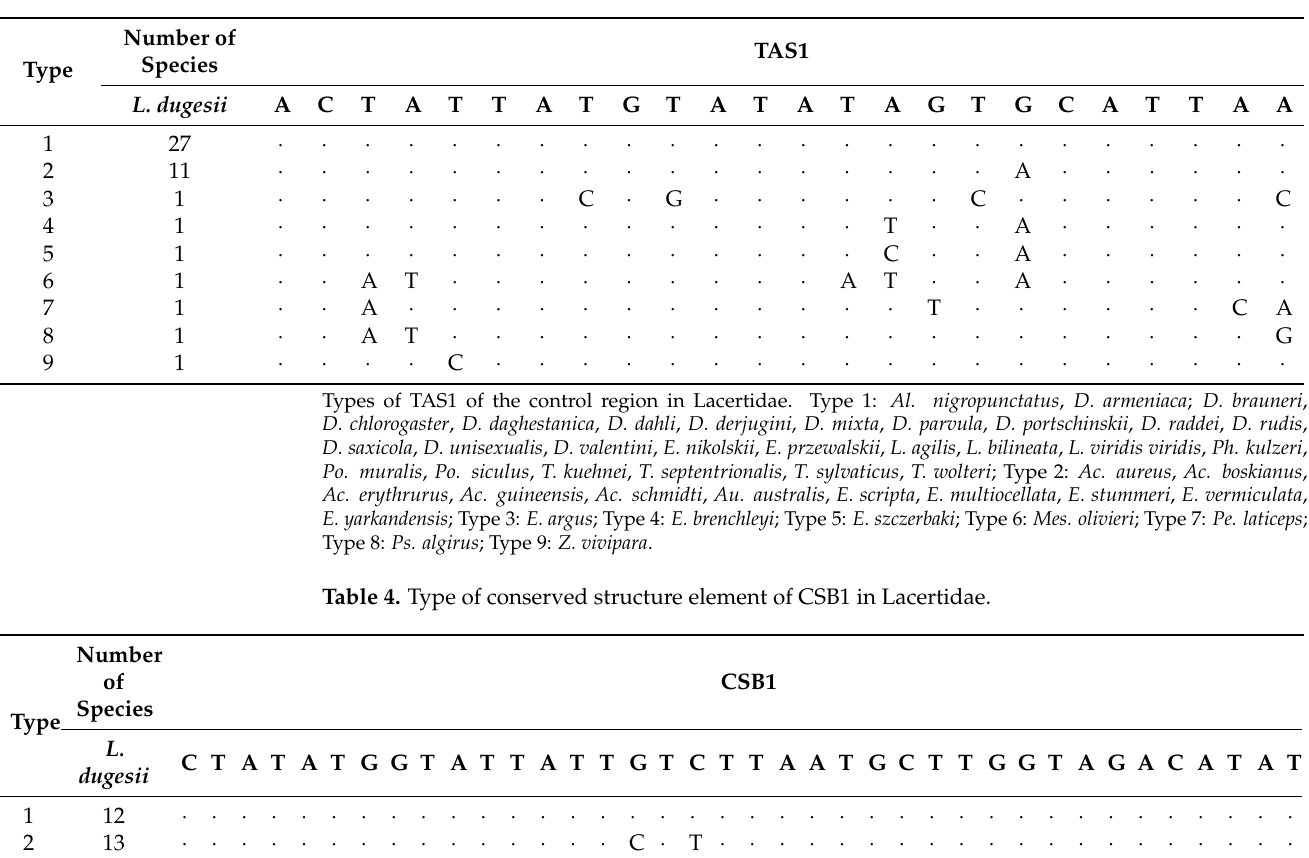
Table 3. Type of conserved structure element of TAS1 in Lacertidae.